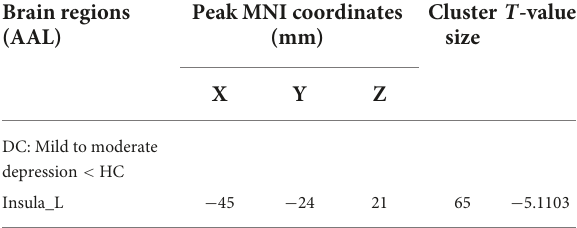
Coordinates of the maximal point of the cluster and the associated T -values are shown in Montreal Institute of Neuroscience (MNI) spaces. After a two-sample T -test, the statistical significance threshold was set at voxel P < 0.005 and cluster P < 0.05 with false discovery rate Gaussian random field correction (GRF) correction. Age and gender